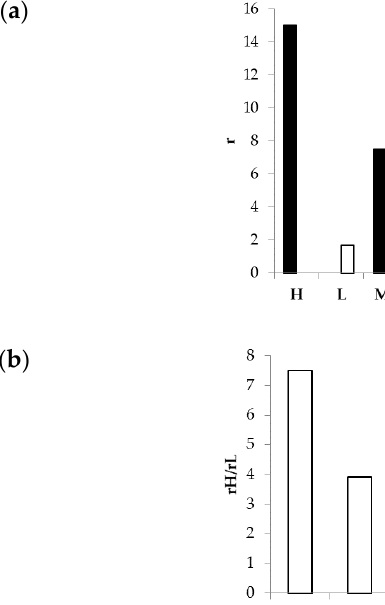
Table 2. Size (μm) of electrospun fibers obtained from H, L, and M solutions (mean value ± SE; n = 30).